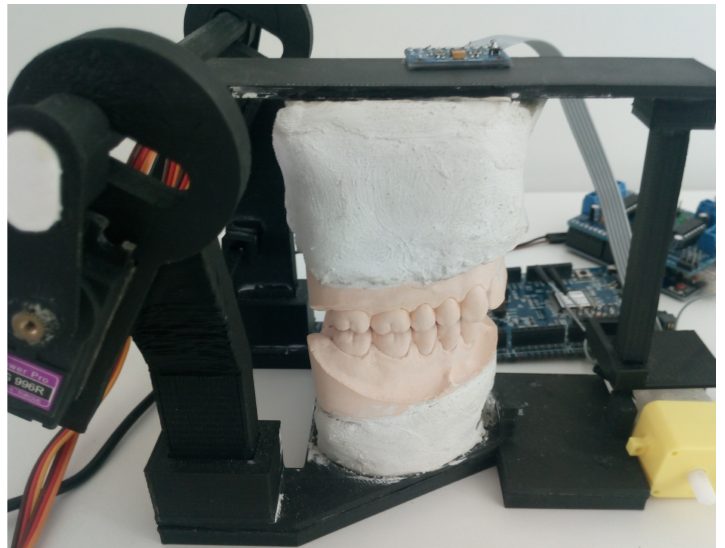
Figure 5. Singlehinge vertical motion articulator with the attached inertial measurement unit